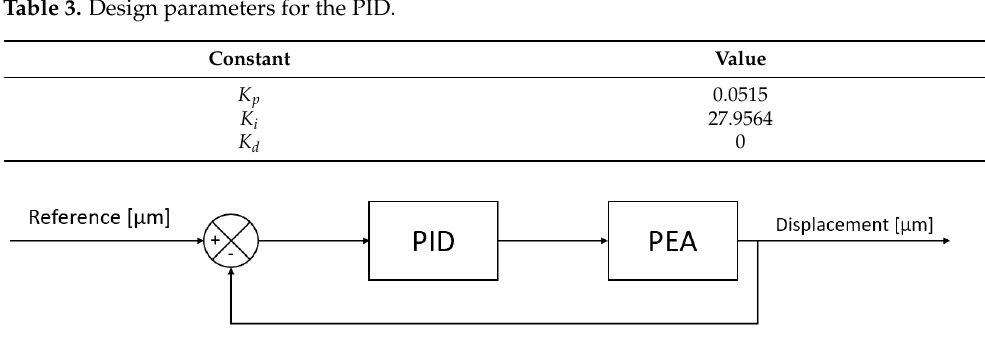
Table 3. Design parameters for the PID.